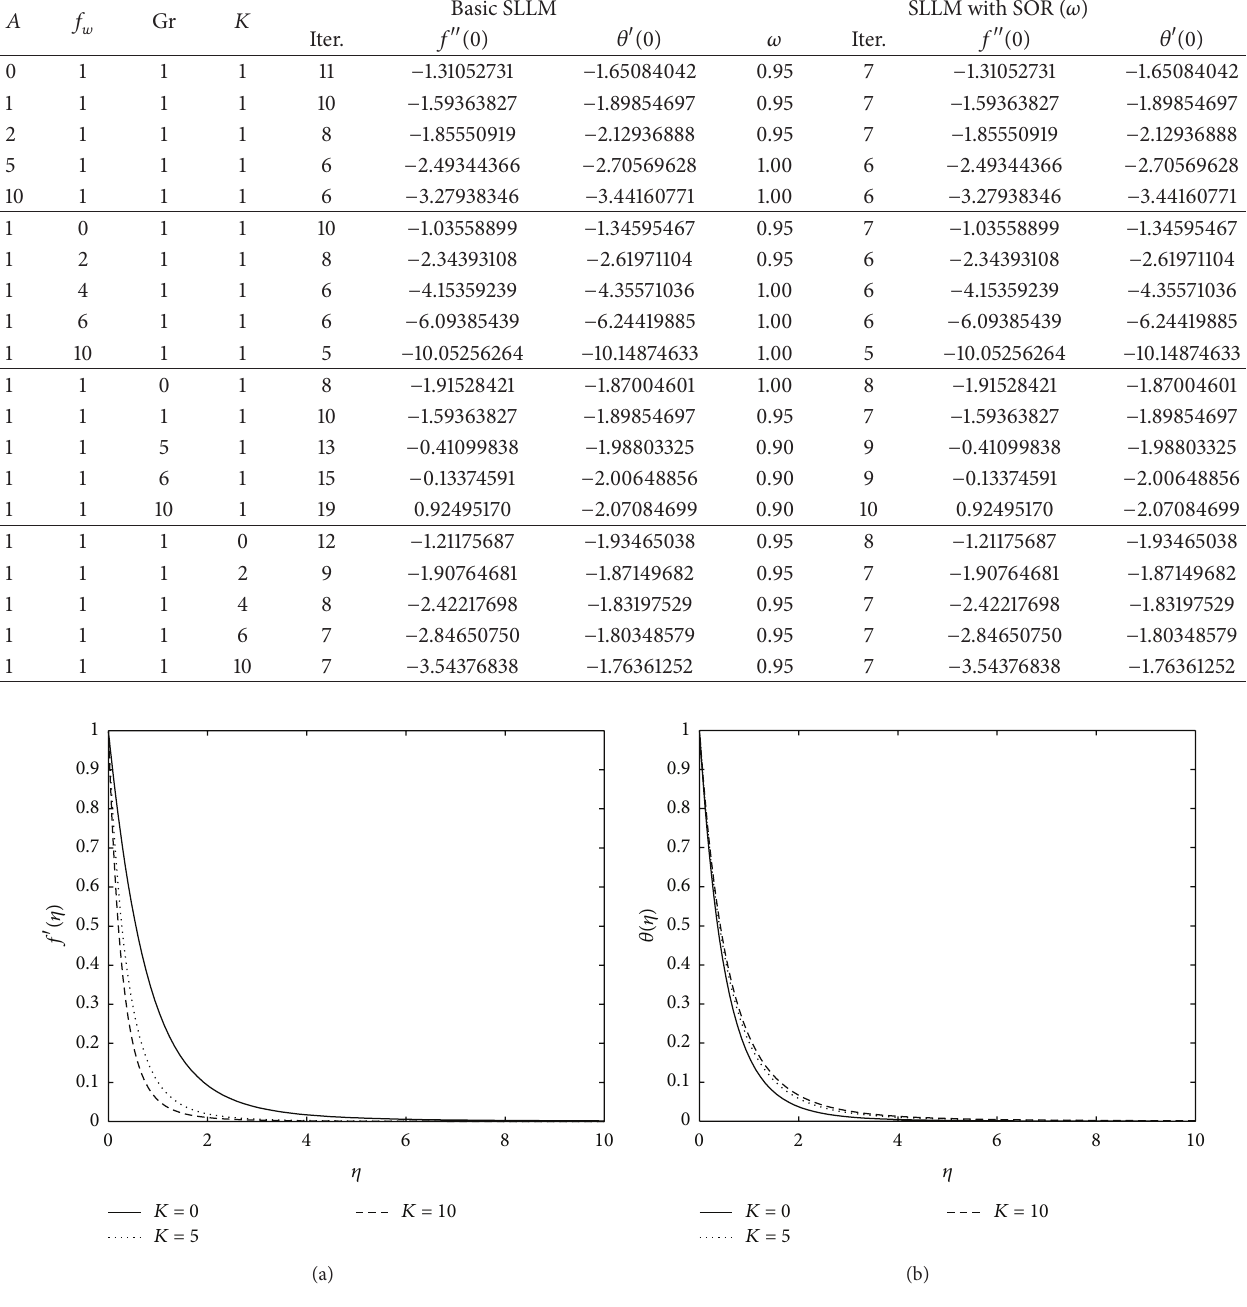
Table 5: Effect of varying 𝐴 , 𝑓 𝑤 , Gr, and 𝐾 on 𝑓 󸀠󸀠 (0) and 𝜃 󸀠 (0) , when Pr = Sc = 𝛾 = Gc = 1 .